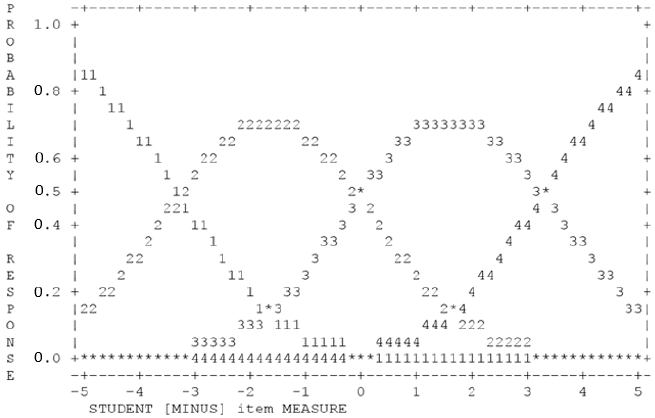
Figure 2. Probability curve for 10IBLP-I scale review.